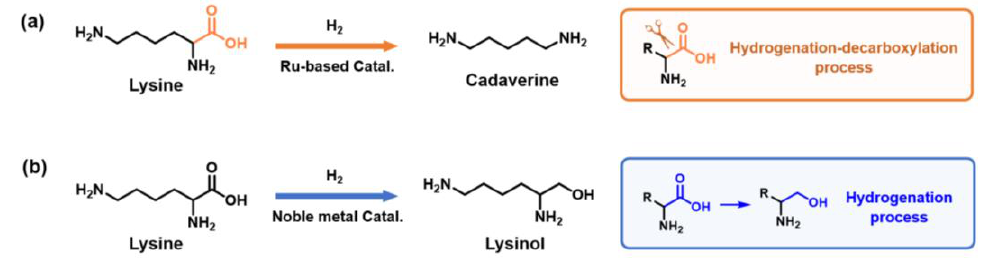
Figure 4. Chemical structure and catalytic processes of ( a ) cadaverine and ( b )